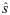
Inference and uncertainty using the posterior.The posterior distribution over s is plotted for the realistic scenario of na = 47, nb = 32, and nab = 20 [line; Eq (6)]. The posterior mean provides our estimate of the true overlap s^ [open circle; Eq (7)], and the interval accounting for at least 90% of the area under the posterior curve provides an equal-tailed 90% credible interval [shading; Eq (8)]. The S˚ estimate is shown for comparison [black cross; Eq (1)], and is typically less than or equal to s^.